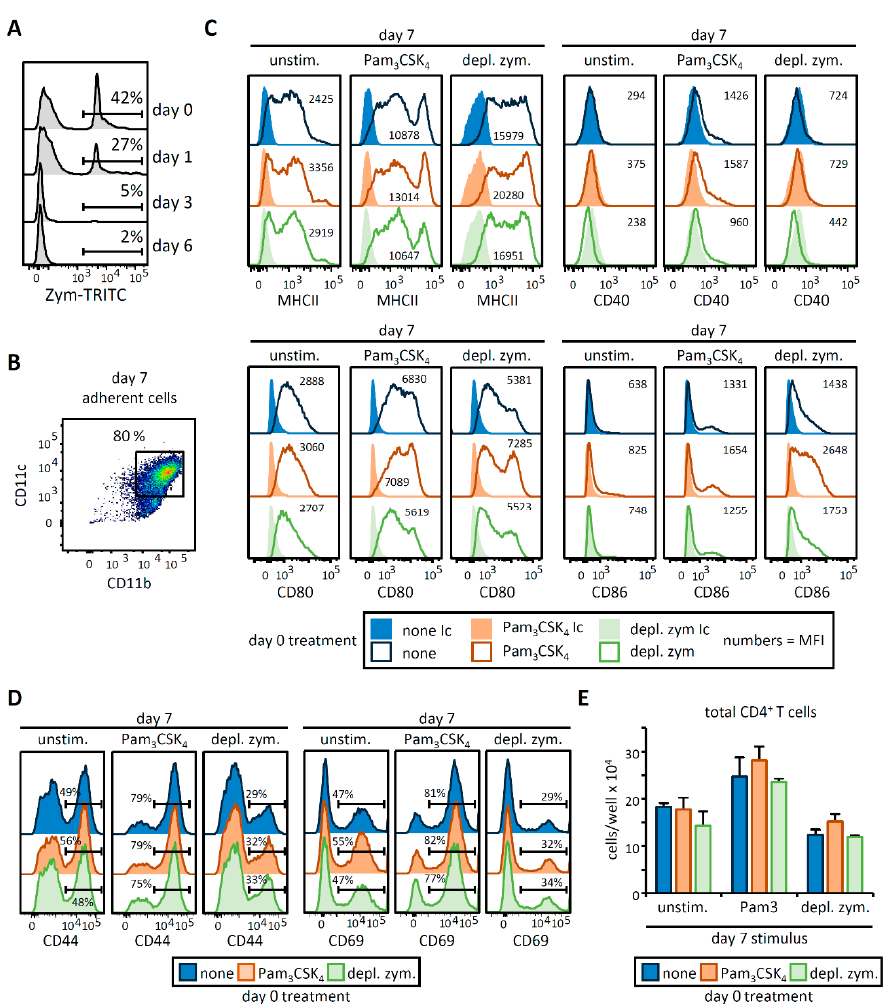
Figure A1. ( A ) Percentage of fluorescently (TRITC) labeled zymosan particles present in the differentiation cultures shown in Figure 1 at different time points measured by flow cytometry. ( B ) CD11b and CD11c expression by the adherent cells recovered from the cultures at day 7 ( C ) Histograms and MFIs (numbers) corresponding to data shown in Figure 1B colormap. ( D ) Histograms and percentage of CD4 + T cells expressing CD44 or CD69 from cocultures obtained as indicated in Figure 2A. ( E ) Total CD4 + T cell numbers in the cocultures obtained as in Figure 2B, data represent means ± SD of triplicate cultures. Results shown are from one experiment representing three independent experiments.